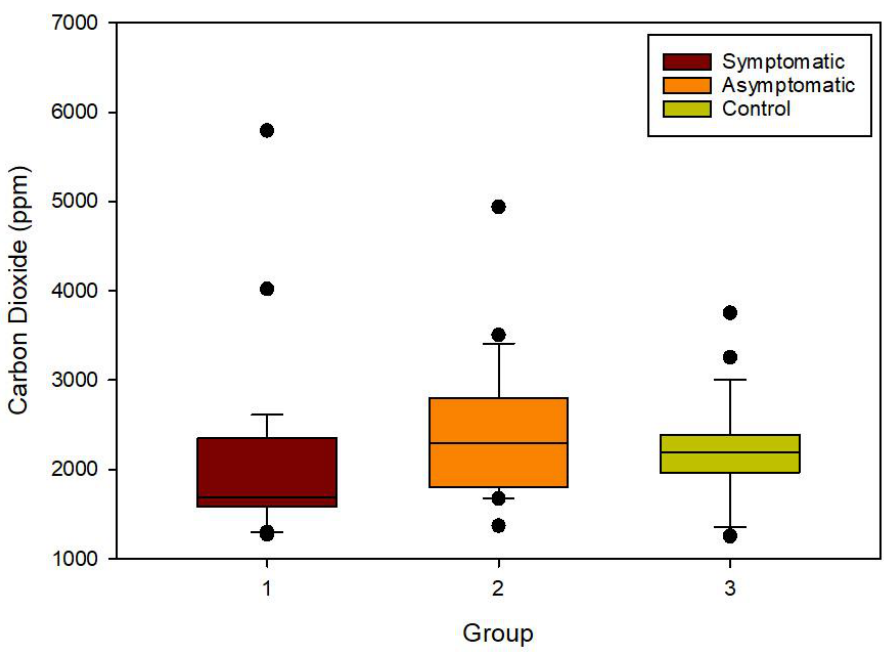
Figure 3. Carbon dioxide levels measured for different patient groups.